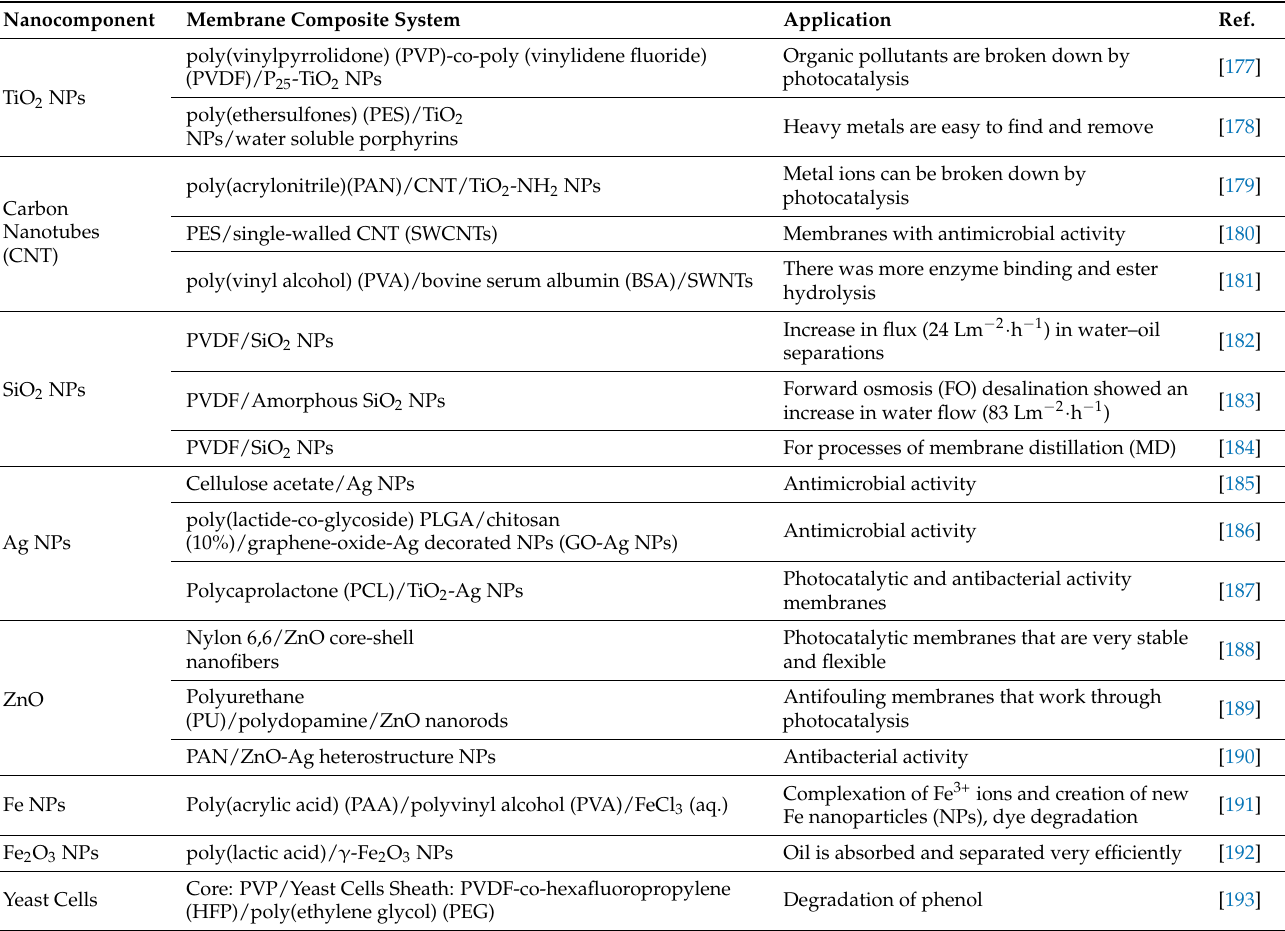
Table 2. Some potential applications for composite nanofibrous membranes that are supported by polymeric matrices in the field of water